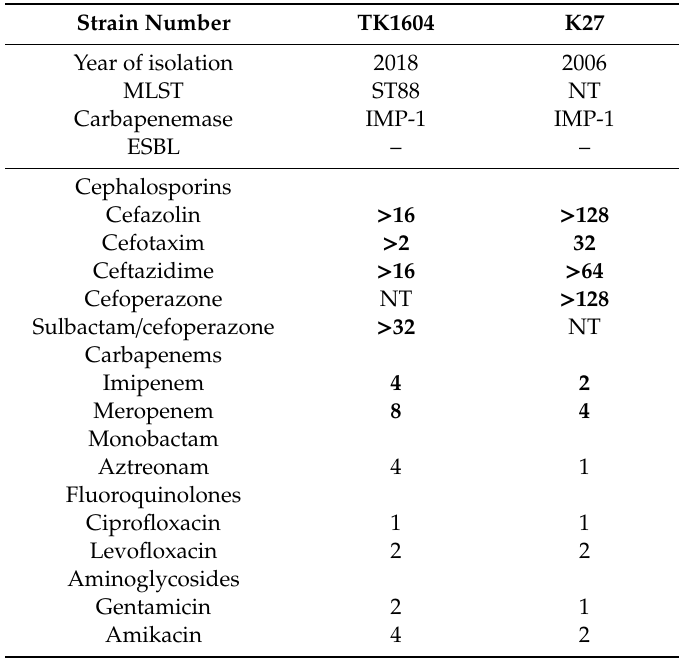
Table 2. Antimicrobial susceptibility profiles of IMP-1-producing K. oxytoca from this study and a previous study [17]. Strain Number TK1604 K27 Year of isolation 2018 2006 MLST ST88 NT Carbapenemase IMP-1 IMP-1 ESBL – – Cephalosporins Cefazolin > 16 > 128 Cefotaxim > 2 32 Ceftazidime > 16 > 64 Cefoperazone NT > 128 Sulbactam / cefoperazone > 32 NT Carbapenems Imipenem 4 2 Meropenem 8 4 Monobactam Aztreonam 4 1 Fluoroquinolones Ciprofloxacin 1 1 Levofloxacin 2 2 Aminoglycosides Gentamicin 2 1 Amikacin 4